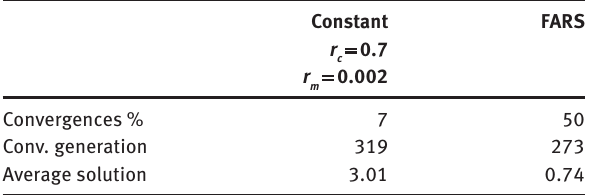
Table 3: Results on the Counting-Ones Problem in Terms of Convergences to the Global Optimum and Generation of Convergence: The Best ( r , r ) Combination for the Constant Approach is c m